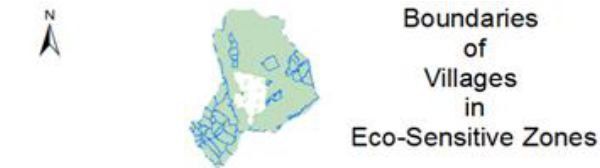
Figure 14 – Boundaries of villages in ESZ of